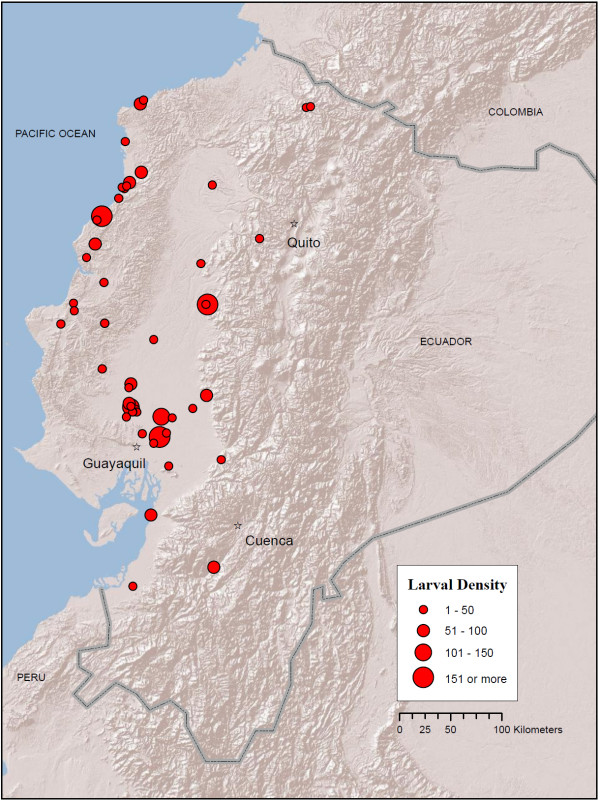
Map of An. albimanus localities in Ecuador (red circles) from larval collections conducted between 2008 - 2010. Circle size (legend) indicates mean number of larvae per dip in a 30-dip sample. Map prepared in ArcGIS v.9.3 with ESRI World Terrain base [59].